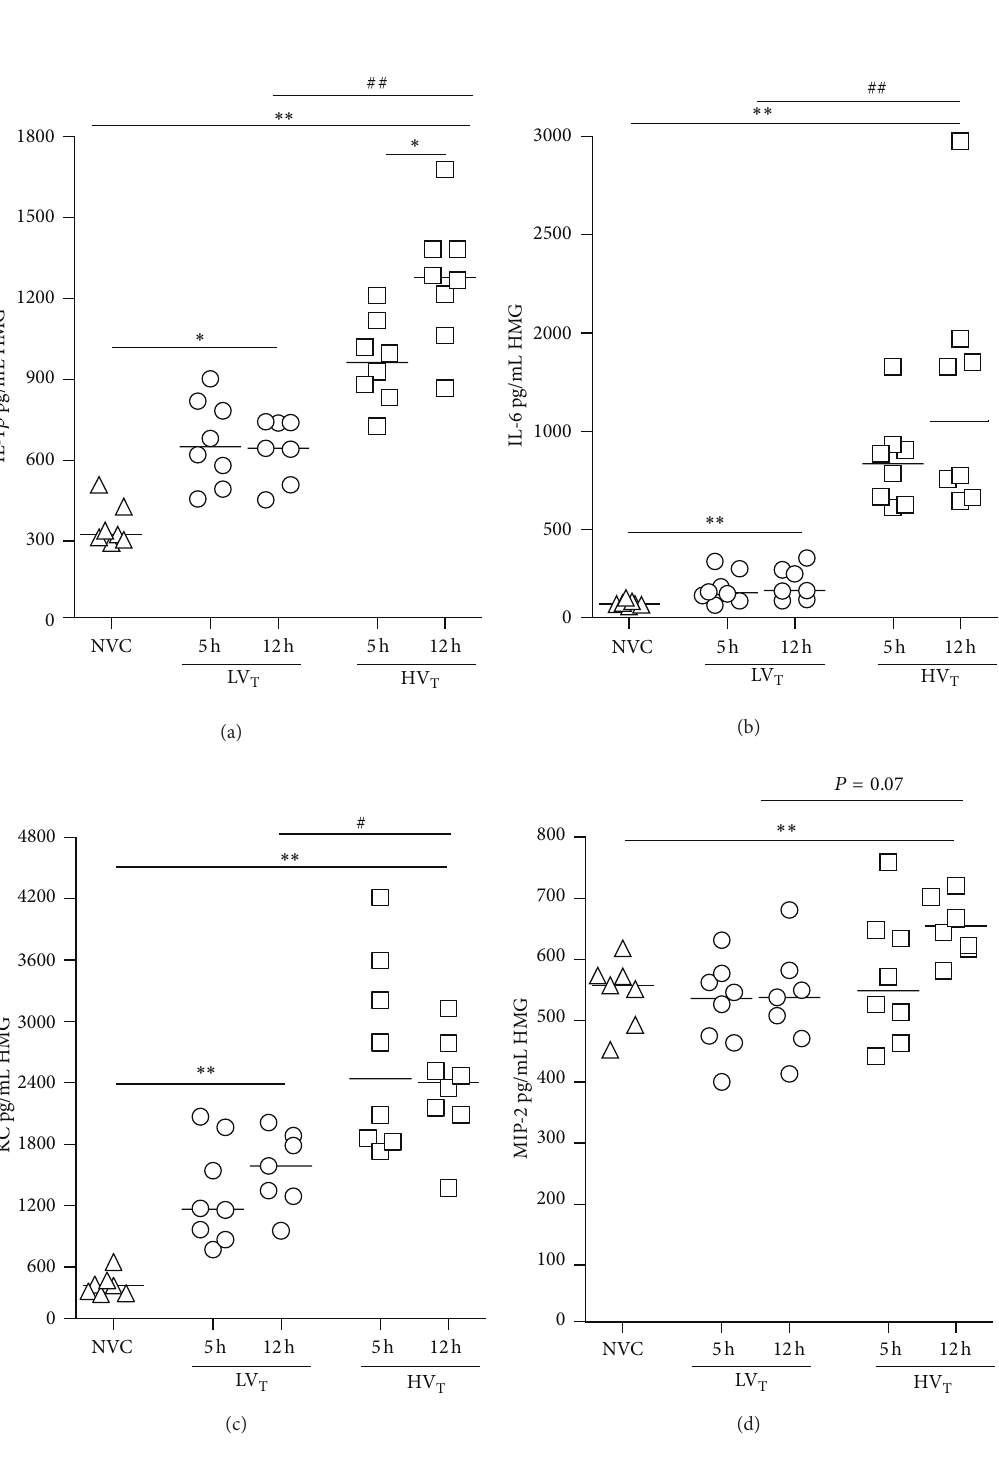
Figure 6: Inflammatory mediators. ((a)-(b)) Protein levels of the proinflammatory cytokines interleukin (IL)-1 𝛽 and IL-6 were determined in supernatant of total lung homogenates (HMG). ((c)–(d)) In addition, protein levels of the chemotactic cytokines keratinocyte-derived chemokine (KC) and macrophage inflammatory protein (MIP)-2 were determined. Data are presented as scatter plot (median) of 7-8 mice per group (triangle = NVC; circle = LV T ; square = HV T ). ∗ Illustrates primary statistical analysis ( ∗ 𝑃 < 0.05 , ∗∗ 𝑃 < 0.01 ); # illustrates secondary statistical analysis ( # 𝑃 < 0.05 , ## 𝑃 < 0.01 ). NVC = nonventilated controls; LV T , HV T = LV T /PEEP or HV T /ZEEP ventilator settings; 5h, 12h = 5 or 12 hours of